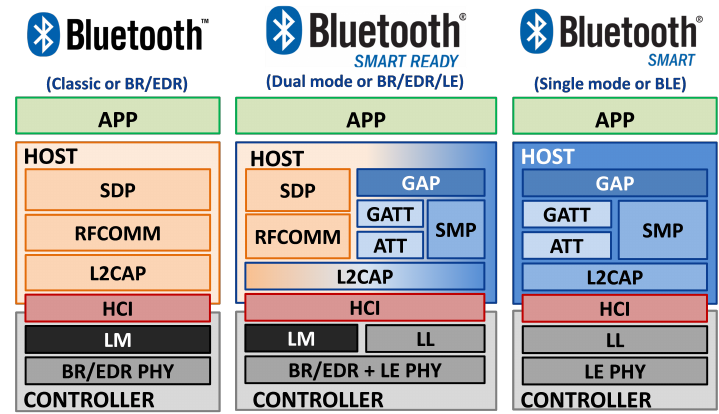
Figure 2. Configuration between Bluetooth versions and device types. On the left is the protocol structure of the BR/EDR, while on the right is the BLE. In the middle is the protocol stack of a device compatible with both Bluetooth versions; this type is called Smart Ready or Dual Mode . Adapted from [52].